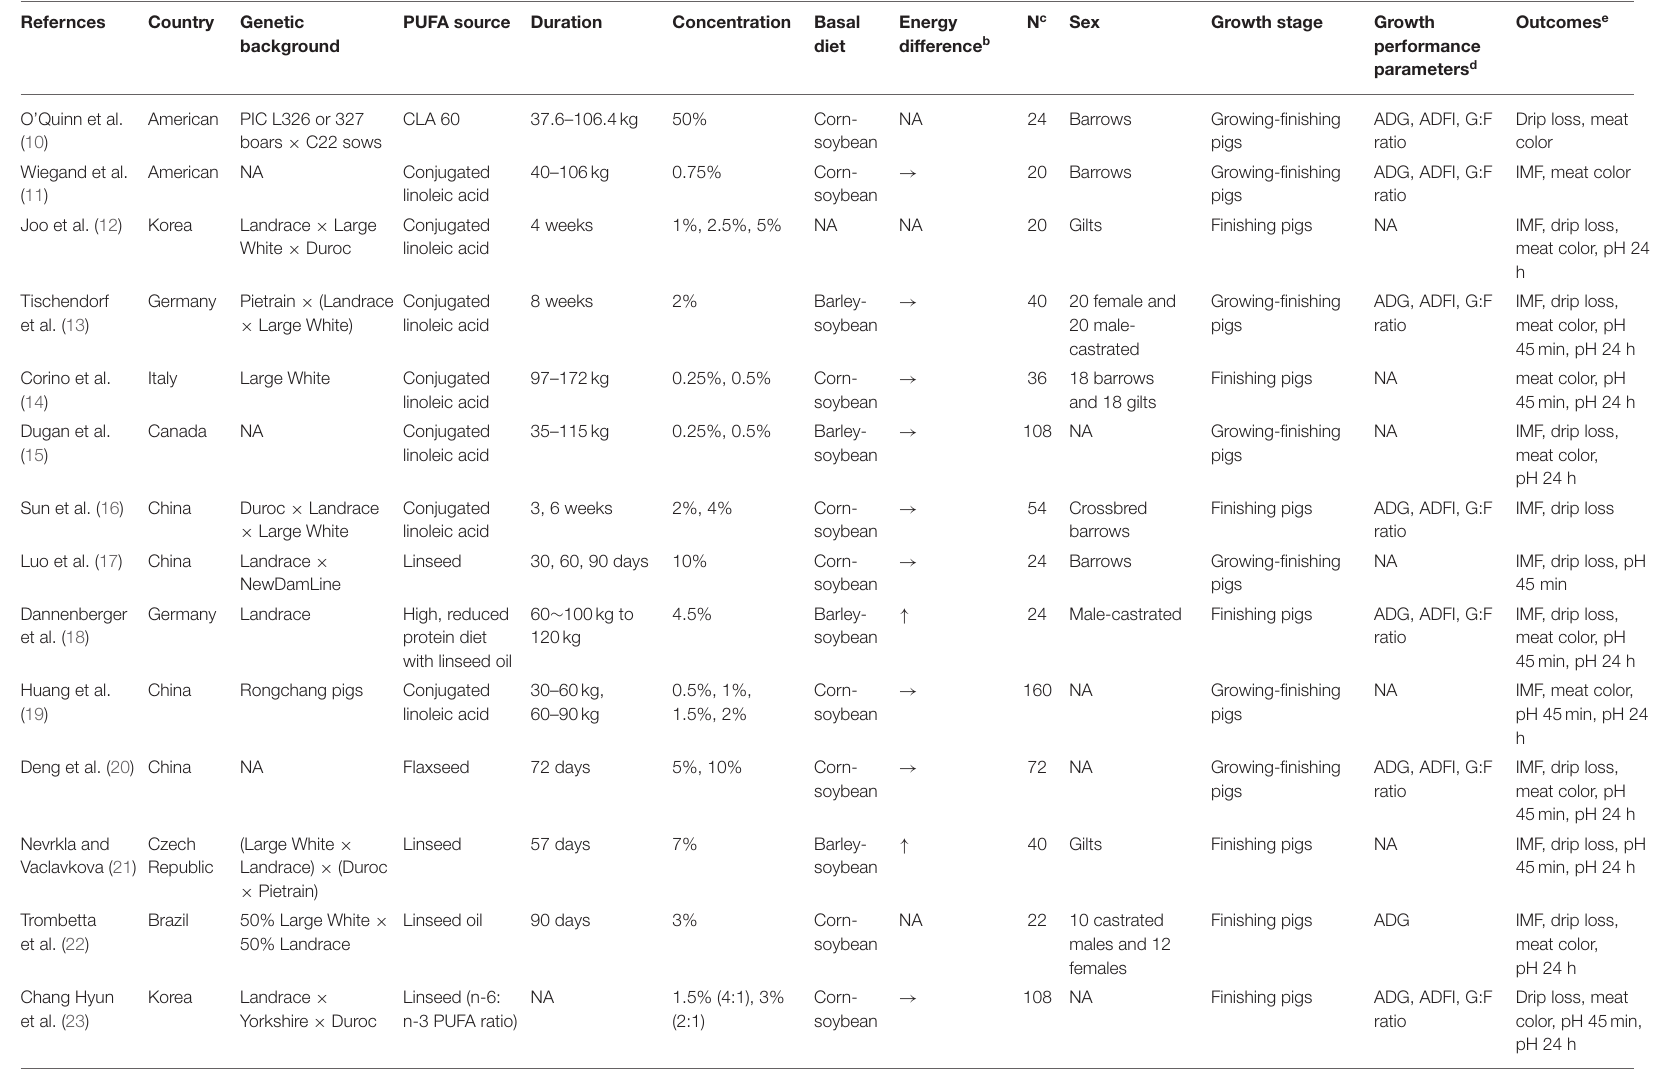
TABLE 2 | Characteristics of included studies a